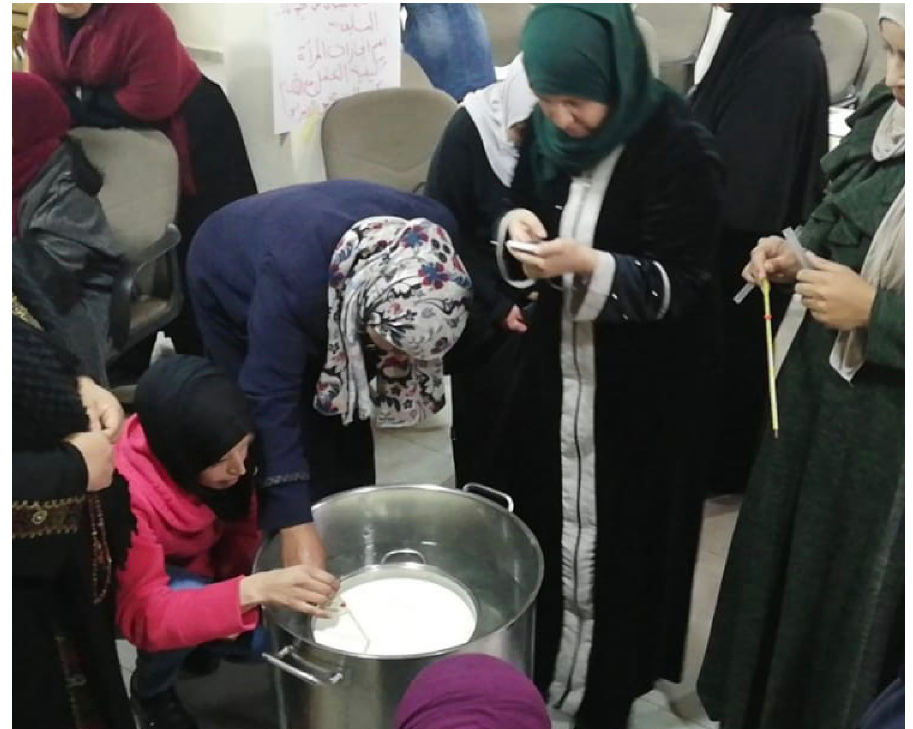
Fig 1. Locals receiving training on how to pasteurize